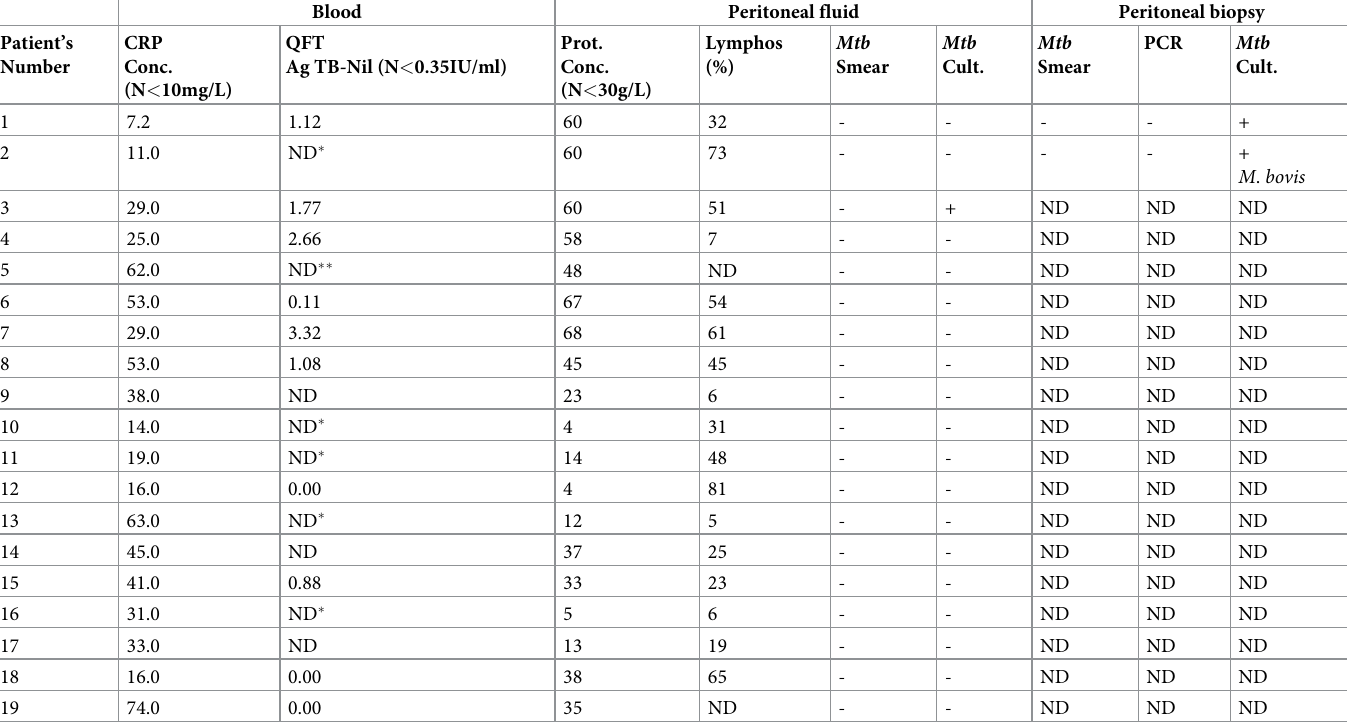
Table 2. Main biological